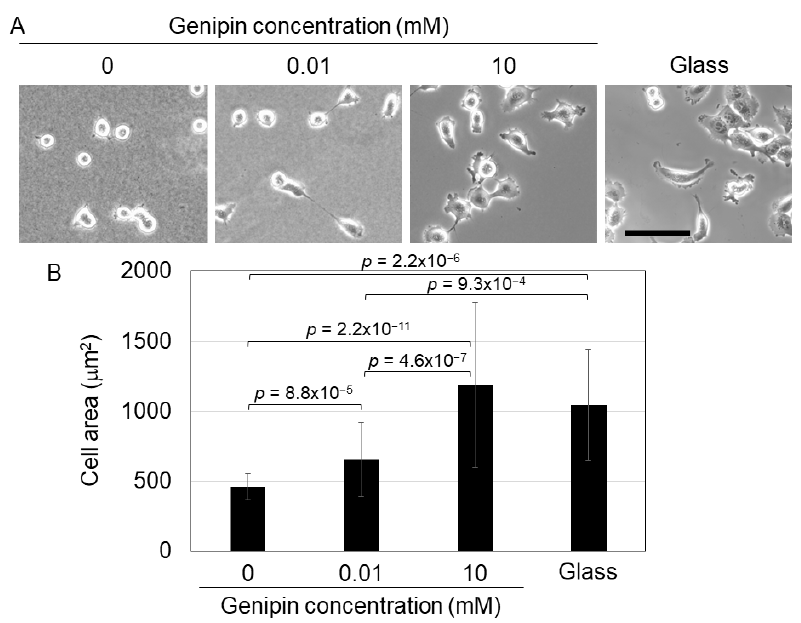
Figure 2. ( A ) Cell morphology of H1299 cells on the 0, 0.01, or 10 mM genipin-mixed collagen gels or collagen-coated glass substrates. Scale bar = 100 μ m. ( B ) Cell area of H1299 cells shown in ( A ). Mean ± S.D. N = at least 23 cells in 3 independent experiments. p value was calculated using Welch’s t -test with Bonferroni correction.